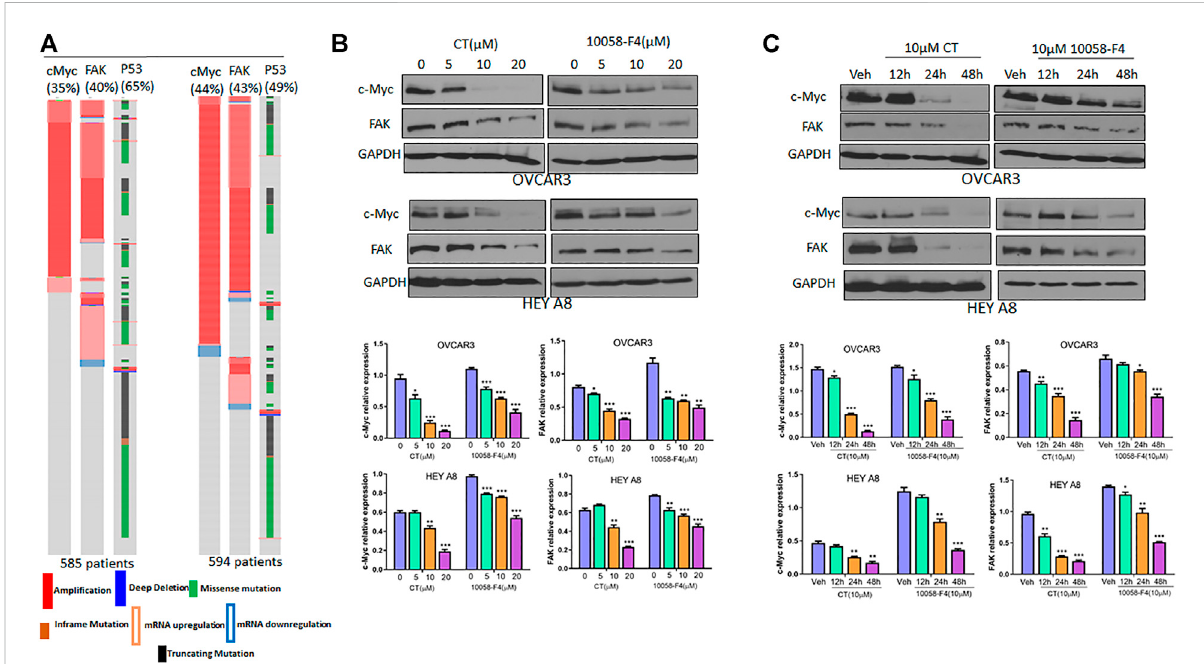
FIGURE 3 CT inhibits c-Myc and FAK expression in ovarian cancer cells. (A) c-Myc and FAK genes were ampli fi ed or upregulated in HGSC in two different datasets. The alteration for each gene was indicated as percentage among those patients. (B) Immunoblot and densitometry analysis of c-Myc and FAKexpressionfollowingtreatmentofOVCAR3 andHEYA8cellsfor24 hwith differentdosesofCTor10058-F4. (C) Immunoblotanddensitometry analysisofc-MycandFAKexpressioninOVCAR3andHEYA8cellsfollowingtreatmentwith10 μ MCTor10058-F4atdifferenttimepoints.Data are presented as mean values ±SD. * p < 0.05, ** p < 0.01, *** p <